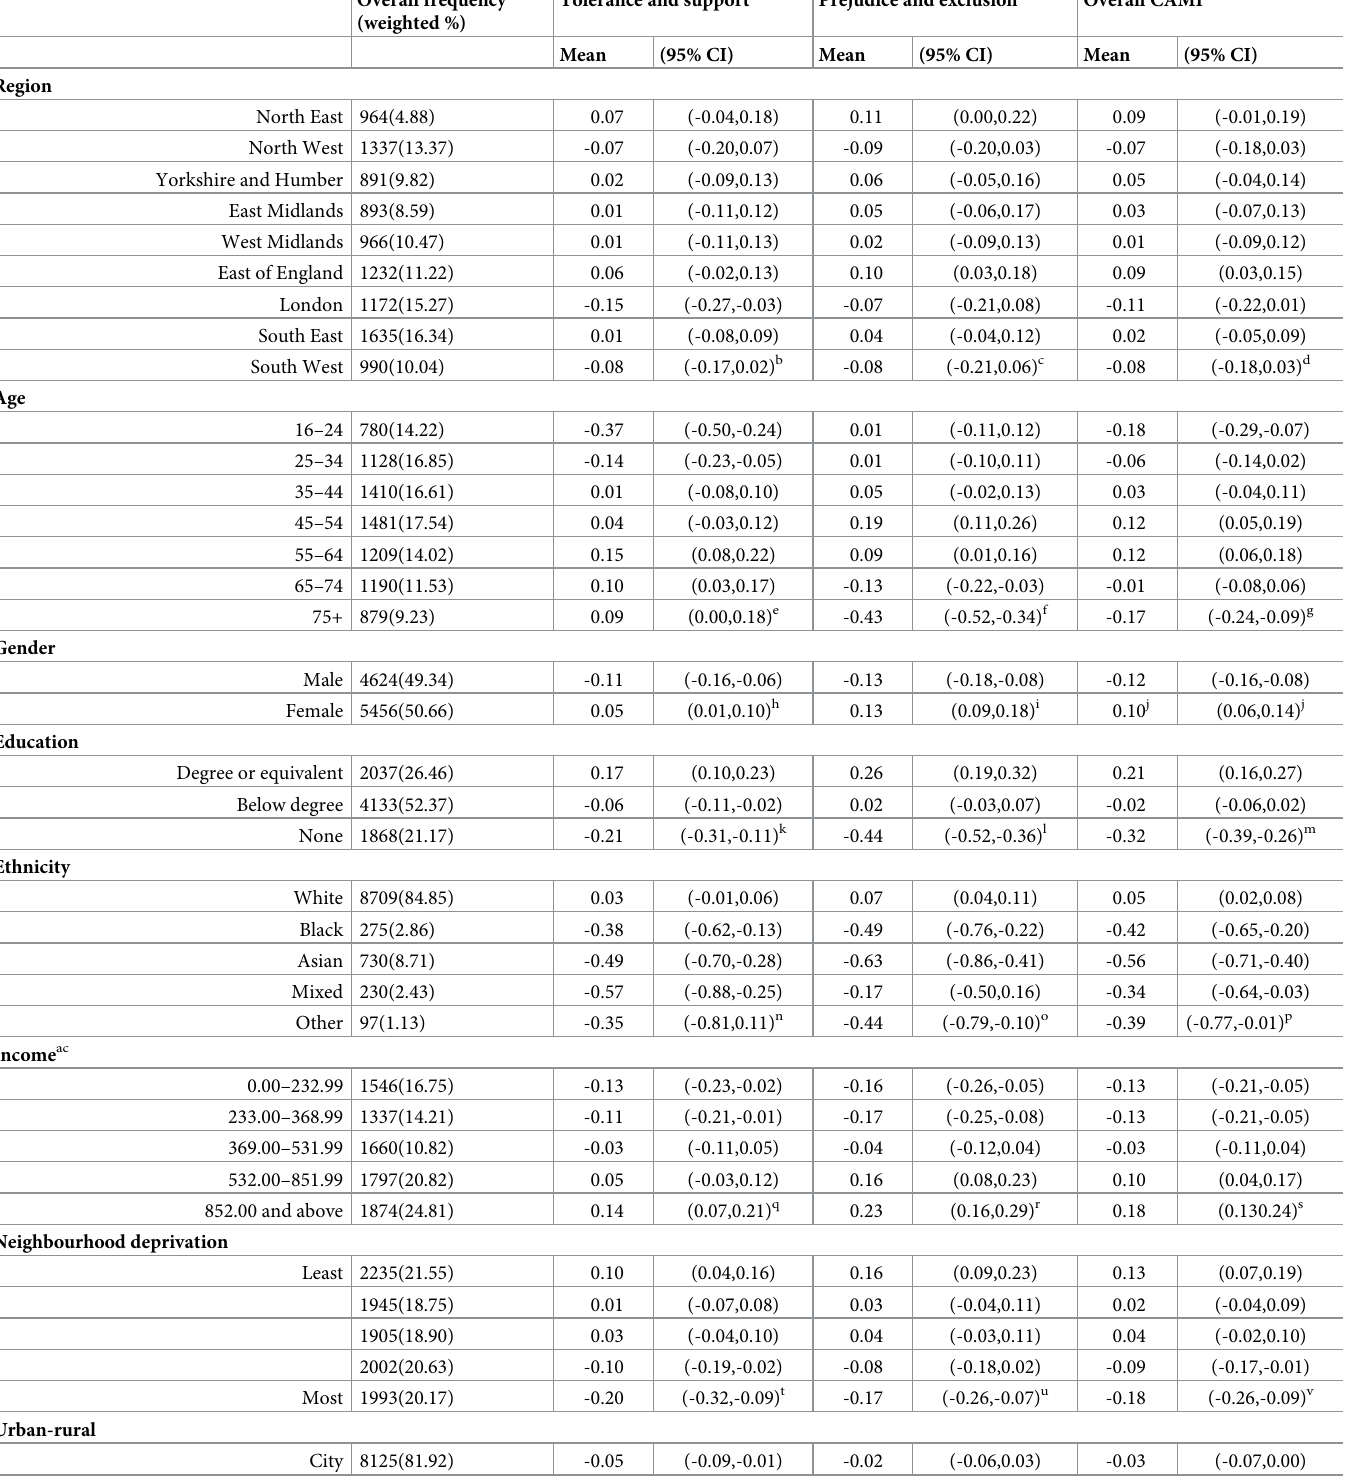
Table 1. Description of study population in terms of mental health-related attitudes, based on responses to the CAMI, from the overall sample (N = 1080). Foot- notes describe numbers of participants for each